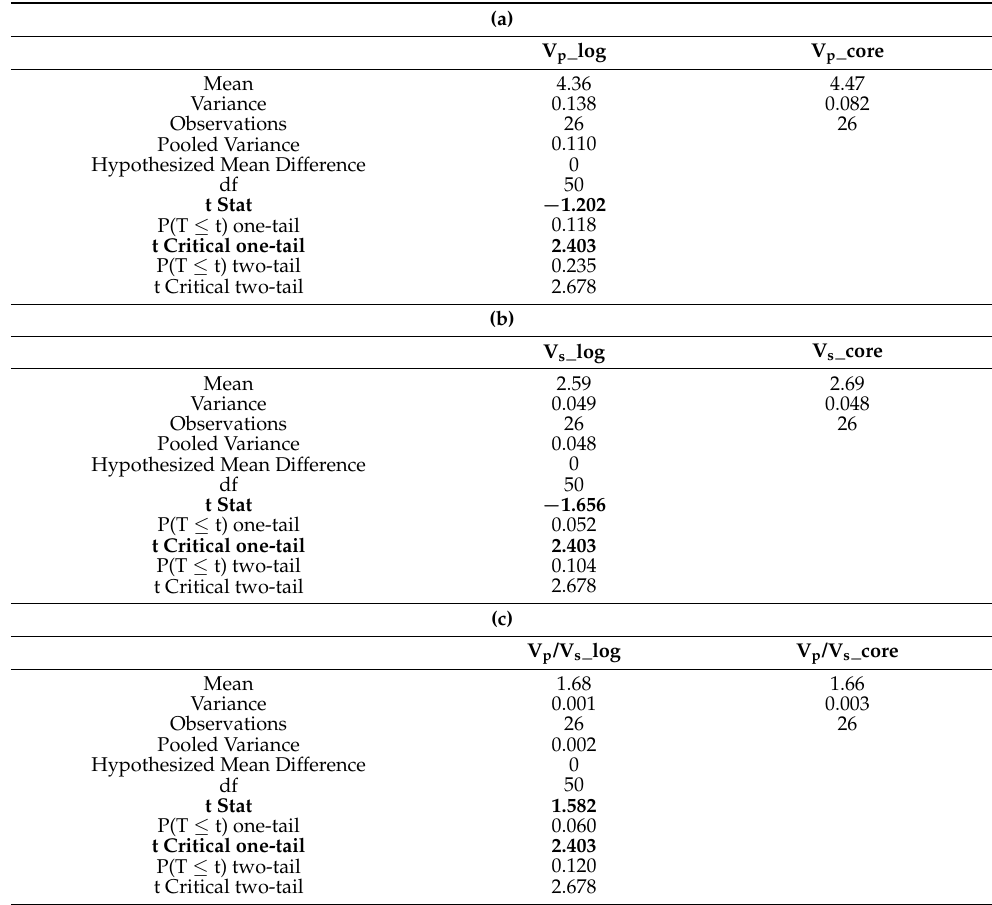
Table 9. (a) Student t -test for the sonic log and ultrasonic core P-wave velocity measurements (after fluid substitution to in situ saturations; with the unlikely assumption that Laboratory S o = 0) for all four formations combined. The results indicate there is no significant difference between the mean of the sonic log and ultrasonic core measurements. (b) Student t -test for the sonic log and ultrasonic core S-wave velocity measurements (after fluid substitution to in situ saturations; with the unlikely assumption that Laboratory S o = 0) for all four formations combined. The results indicate there is no significant difference between the mean of the sonic log and ultrasonic core measurements. (c) Student t -test for the sonic log and ultrasonic core V p /V s ratio measurements (after fluid substitution to in situ saturations; with the unlikely assumption that Laboratory S o = 0) for all four formations combined. The results indicate there is no significant difference between the mean of the sonic log and ultrasonic core velocity